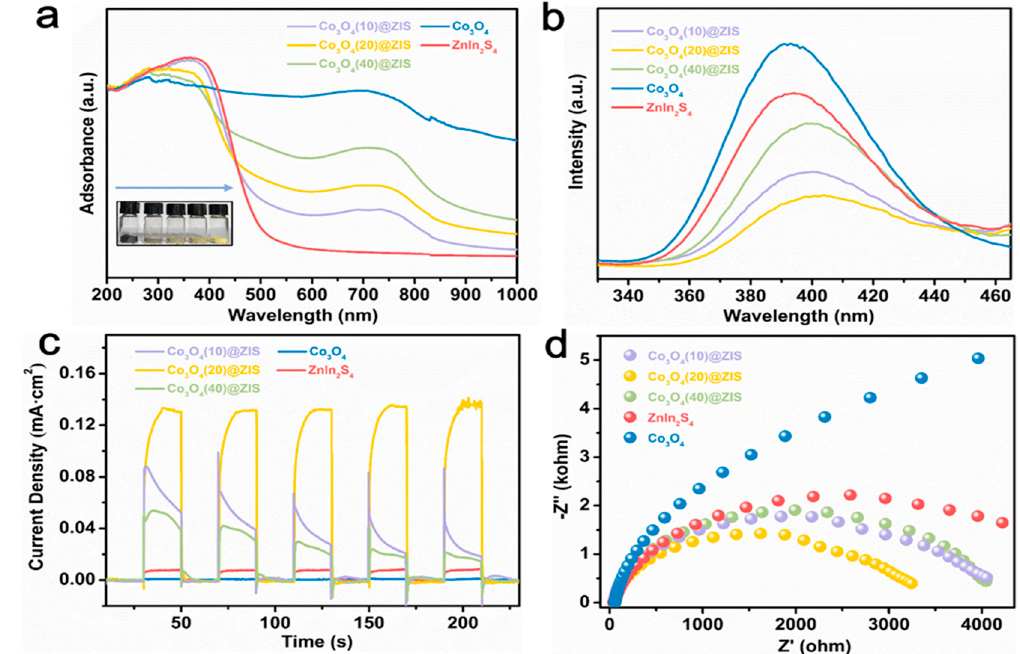
Figure 8. ( a ) DRS plots; ( b ) PL plots; ( c ) photocurrent data; ( d ) EIS data for all